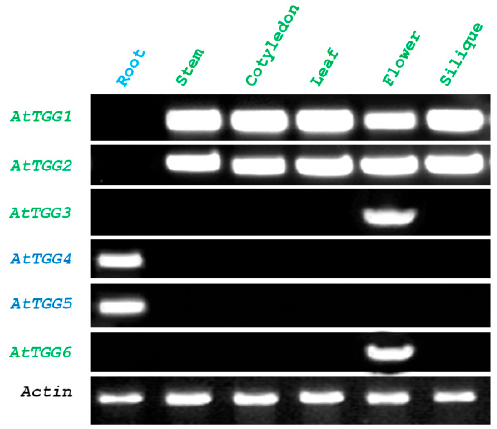
Figure 1. RT-PCR analysis of the myrosinase gene family in Arabidopsis thaliana . An actin gene ( ACT2 , U41998) was used as control.